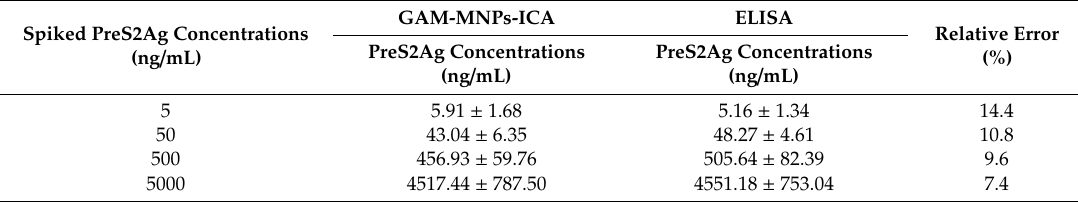
Table 1. Accuracy validation of GAM-MNPs-ICA using the ELISA kit (n = 3). Spiked PreS2Ag Concentrations (ng / mL)